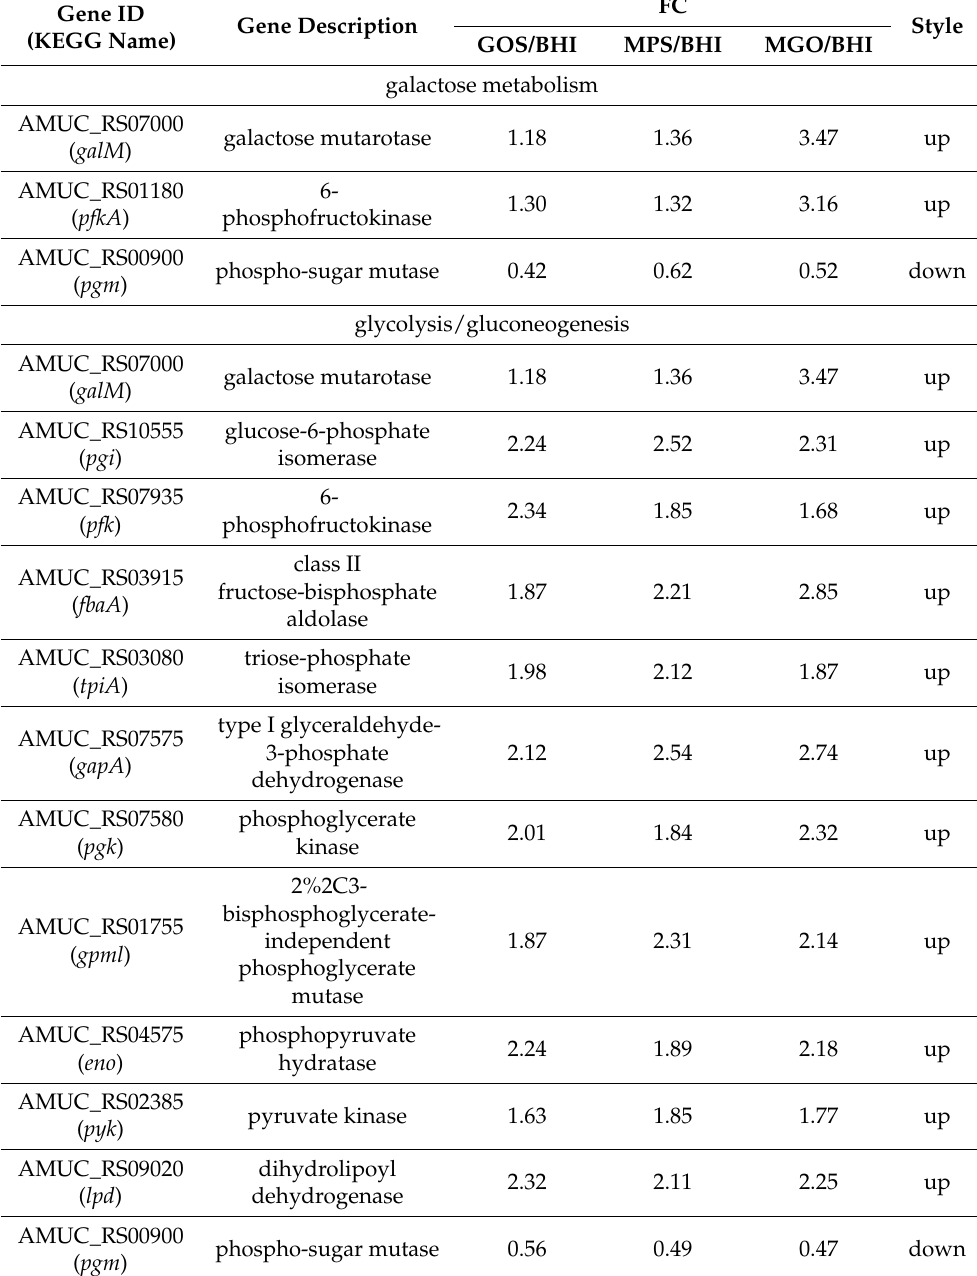
Table 4. Effect of different prebiotics on gene transcription in A. muciniphila cultured for 6